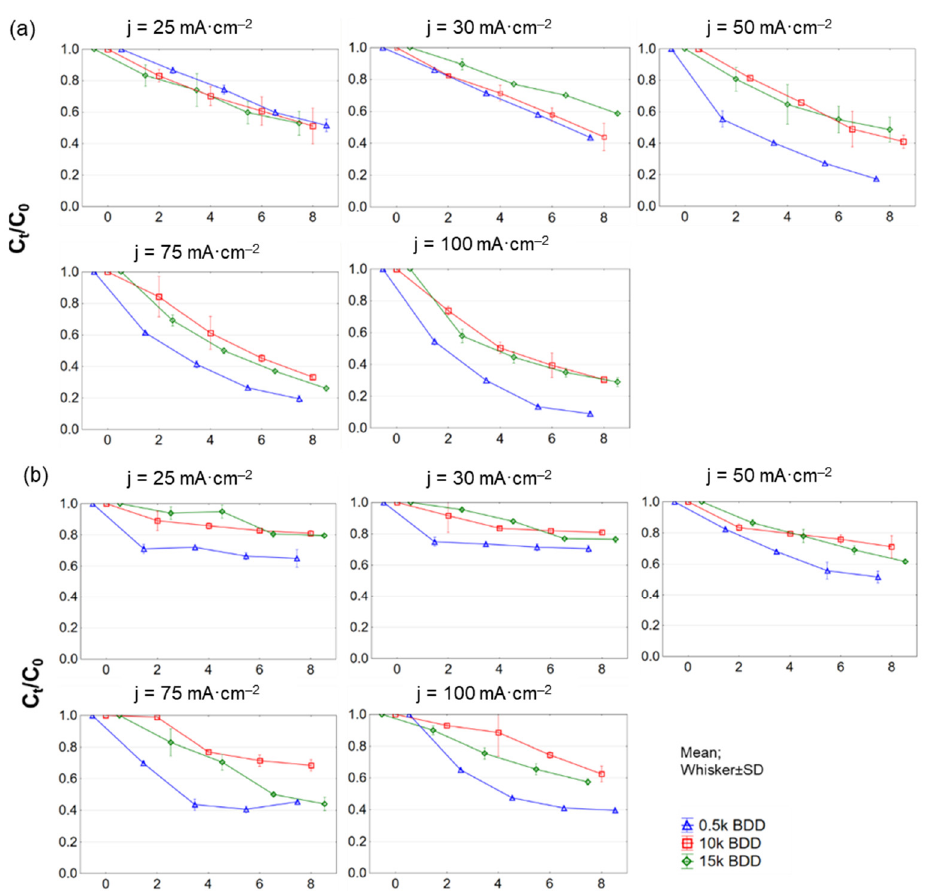
Figure 5. Removal of ( a ) COD and ( b ) N − NH 4+ during 8 h test of LL treatment with different BDD anodes and current densities (25–100 mA·cm − 2 ) expressed as normalized concentration C t /C 0.